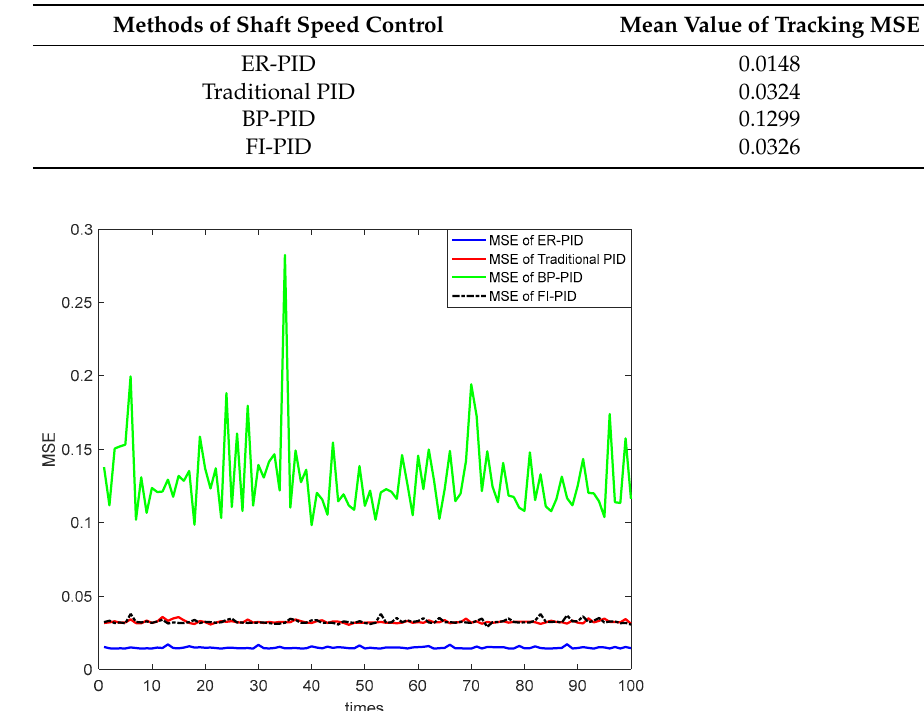
Figure 14. Tracking MSE of the ER ‐ PID controller.